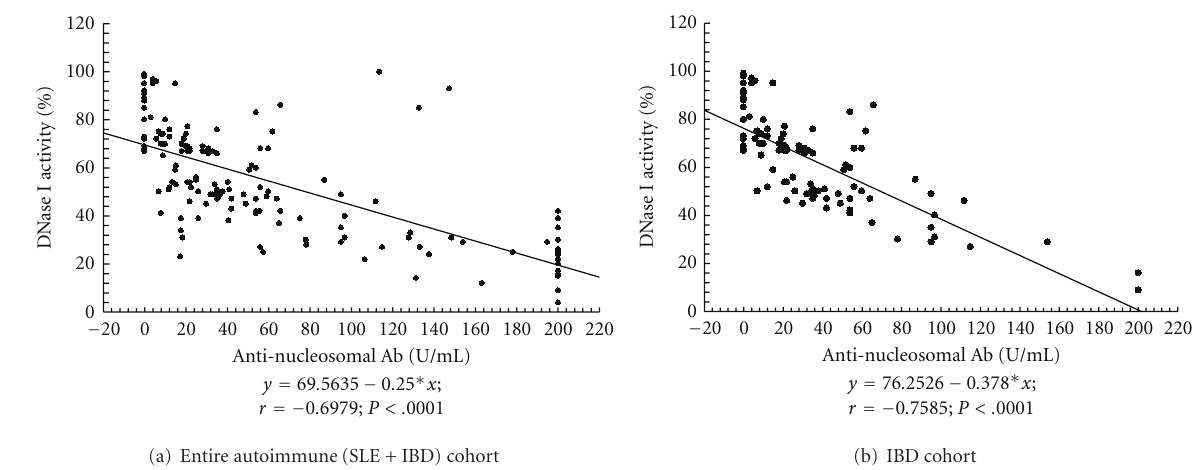
Figure 3: Correlation of DNase I activity with the level of antinucleosomal antibodies. DNase I: deoxyribonuclease I; Ab: antibodies.